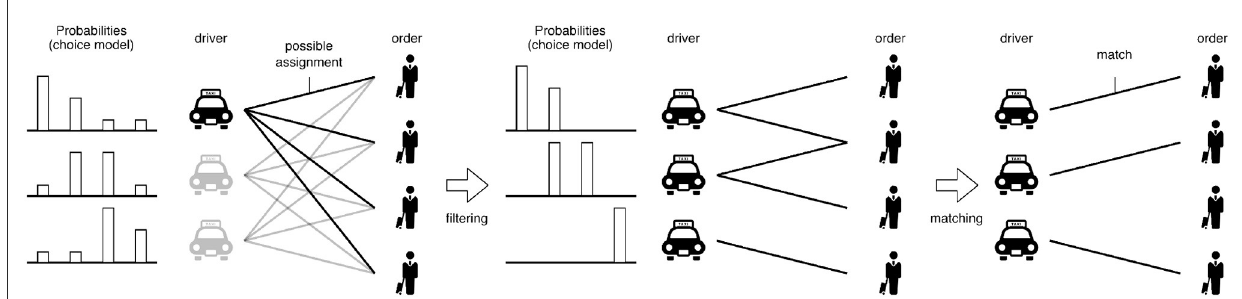
FIGURE2 Concepts of the information disclosure, where probabilities, drivers, and orders are illustrated. In the first step, choice probabilities are optimized by selecting disclosures in the ID problem to clarify the structure among drivers and orders. In the second step, we try to solve the matching problem.